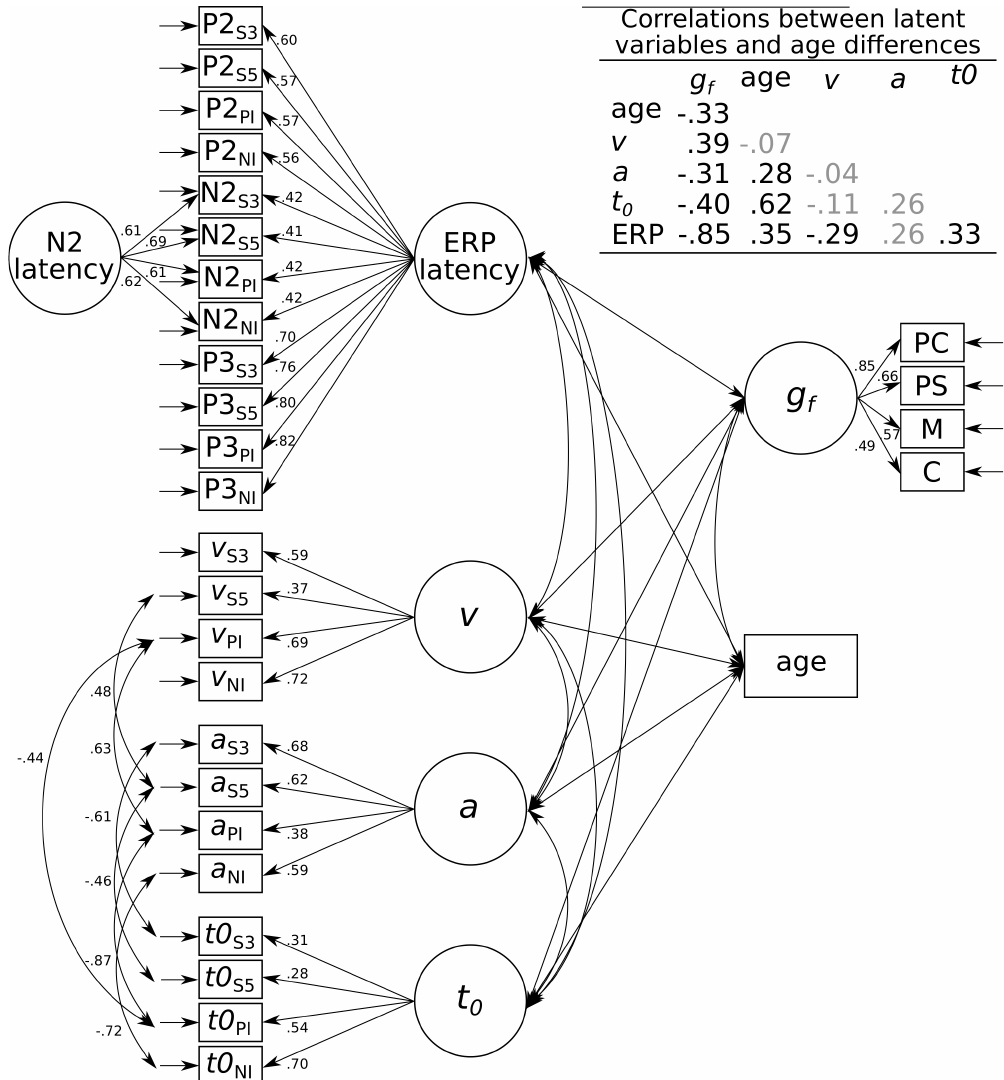
Figure 3. Graphical illustration of the associations between age differences, fluid intelligence, diffusion model parameters, and ERP latencies. Standardized residual correlation coefficients are shown next to paths, whereas standardized correlations between latent variables and age differences are shown in the table in the upper right corner with non-significant correlations shaded in grey. v = drift rate; a = boundary separation; t 0 = non-decision time; ERP = event-related potential; g f = fluid intelligence; S3 = Sternberg task, memory set 3; S5 = Sternberg task, memory set 5; PI = Posner letter matching task, physical identity; NI = Posner letter matching task, name identity; PC = processing capacity; PS = processing speed; M = memory; C = creativity. N =